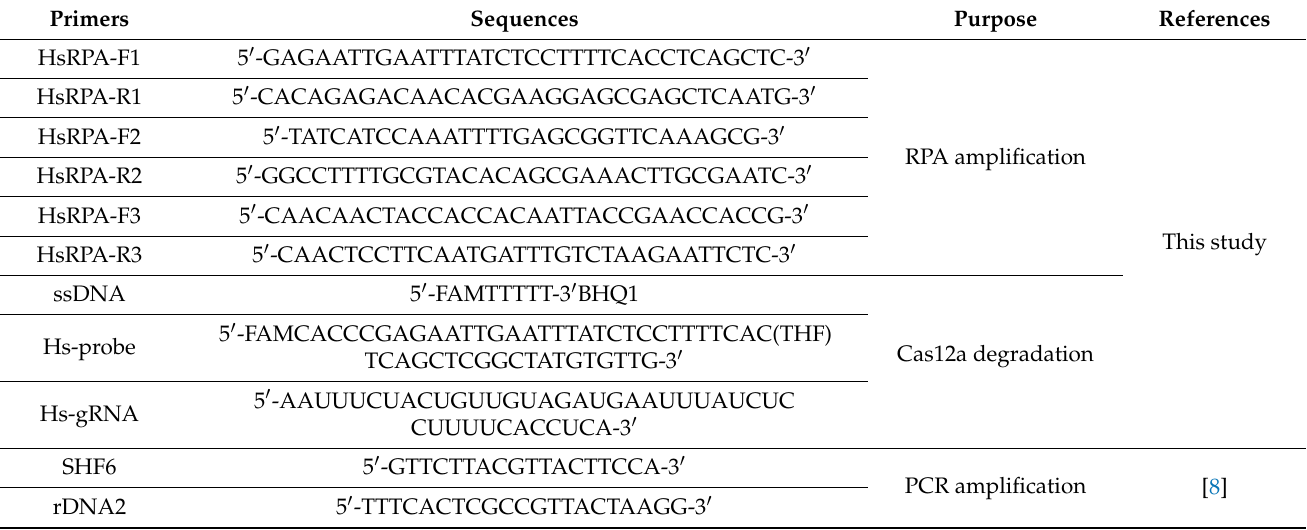
Table 1. Codes and sequences of primers, probes, and gRNA used in this